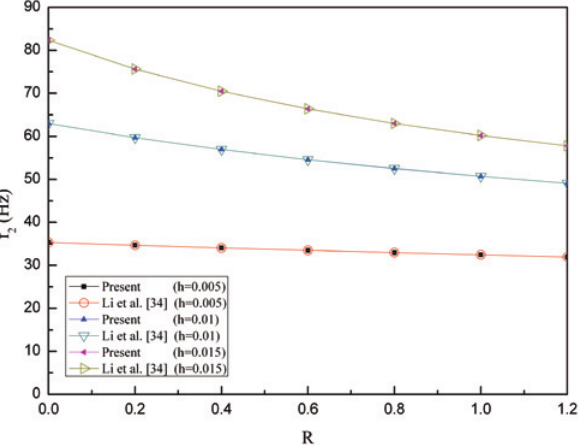
Figure 5 The second-order frequency of the clamped square com- posite laminates with uniform bonding imperfections.